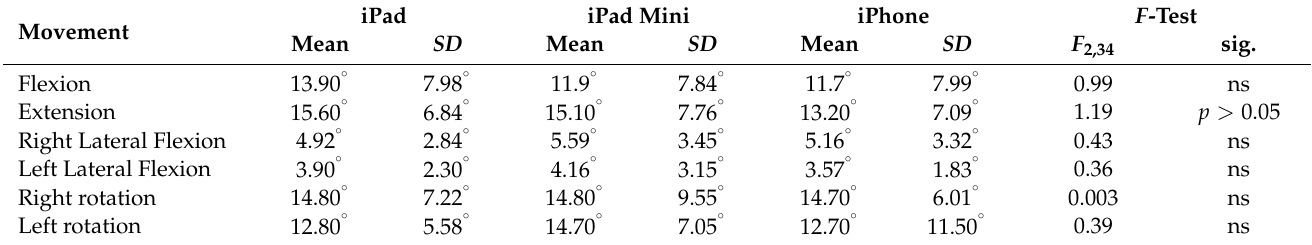
Figure 6. Maximum ROM achieved (in degrees) by device for each direction of the cervical area. Table 2. Summary in terms of mean and standard deviation of the maximum ROM achieved by device for each direction of movement. Results of the F -Tests performed: value of the F Statistic and significance (* p <